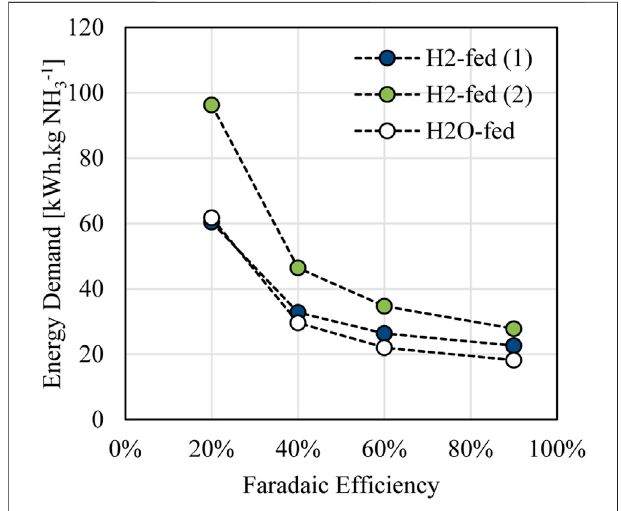
FIGURE 10 | Energy demand for different process options dependant on the faradaic ef fi